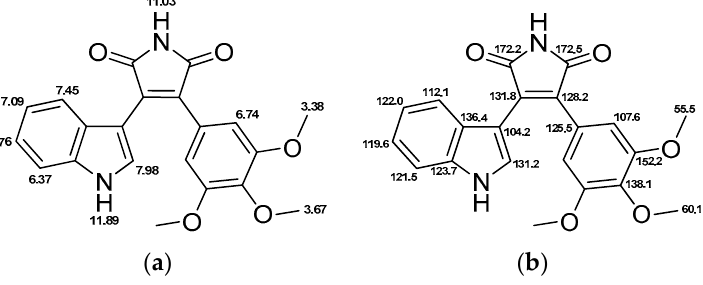
Figure 9. Chemical structure of 1 and relevant NMR shifts for ( a ) 1 H-NMR; and ( b ) 13 C-NMR.